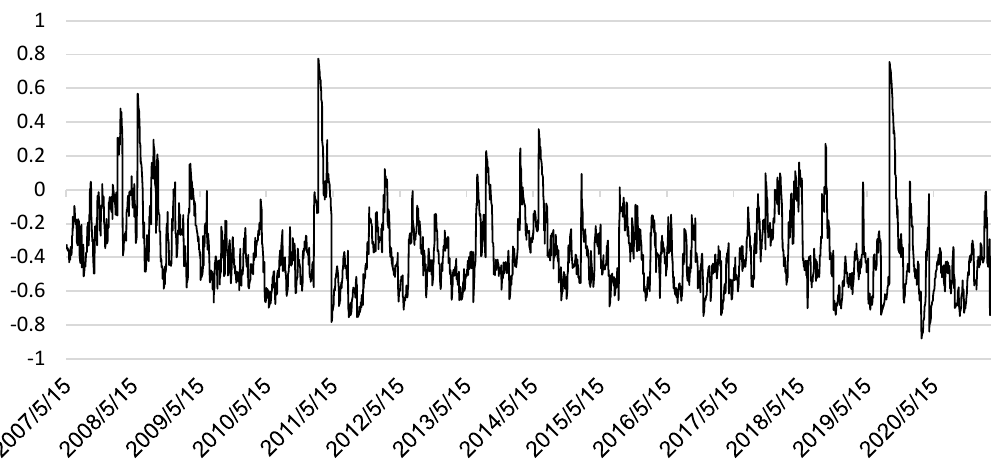
Figure 3. Estimation of the conditional correlation coefficient for the relationship between Crude Oil Future Contract returns (rCL) and changes in the CBOE Crude Oil Volatility Index (dOVX) in the entire period.